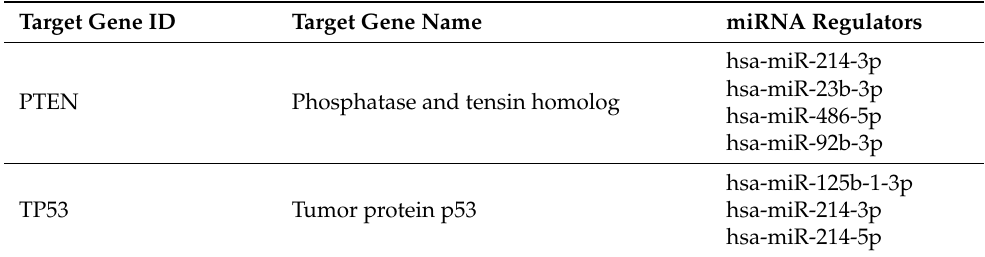
Table 6. Common targets of SF EV miRNAs found to be significantly enriched in the joints of RA patients with low-grade